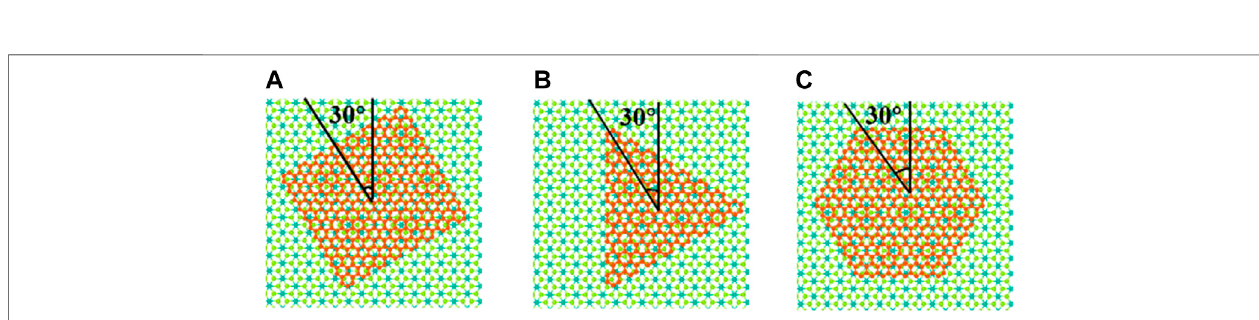
FIGURE1| Schematicdiagramofthemodelusedformoleculardynamicssimulations. (A – D) Crystalstructurediagrams,where (A) MoS 2, (B) NbSe 2, (C) graphene and (D) α -Te are shown. (E) Side view of the simulation model. The sheet is connected to a spring that slides at a constant speed over different substrates (MoS 2 and NbSe 2 ).